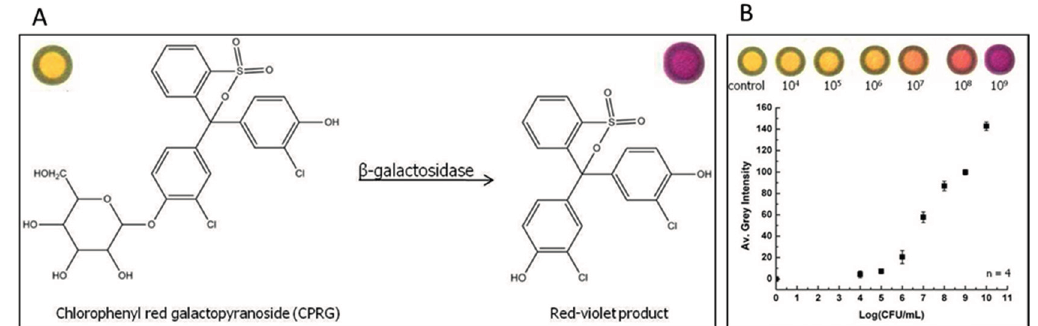
Figure 6. ( A ) Schematic shows the enzymatic reaction between galactosidase and chlorophenyl red galactopyranoside; ( B ) Calibration curve for detection of E. coli has been drawn for determination of the limit of detection for live bacterial assay (reprinted with permission from [99]; copyright 2015 American Chemical Society).